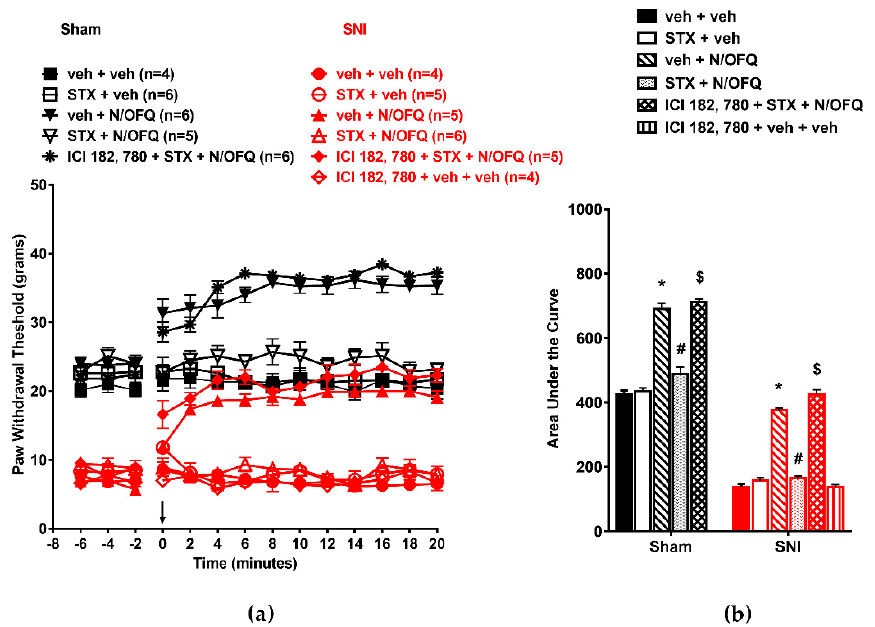
Figure 10. NOP-mediated antihypersensitivity was rapidly attenuated by Gq-mER activation in male rats: ( a ) SNI significantly reduced PWTs compared to the sham group. N / OFQ (10 nM) increased PWTs in both the sham and SNI groups. STX (10 nM) abolished the N / OFQ-induced increase in PWTs. Pretreatment with mER antagonist (ICI 182,780) restored an N / OFQ-induced increase in PWTs. ( b ) AUC analysis confirmed these e ff ects, with a significantly reduced AUC in the SNI groups, N / OFQ significantly increasing it, and STX attenuating the e ff ect of N / OFQ in an antagonist-reversible manner. Here, * p < 0.05 compared to veh + veh; # p < 0.05 compared to veh + N / OFQ; $, p < 0.05 compared to STX + N / OFQ. Taken together, these behavioral data suggest that simultaneous or selective activation of any spinal mER rapidly attenuated spinal NOP-mediated antinociception in the sham groups and tactile antihypersensitivity in the nerve-injured OVX female and male